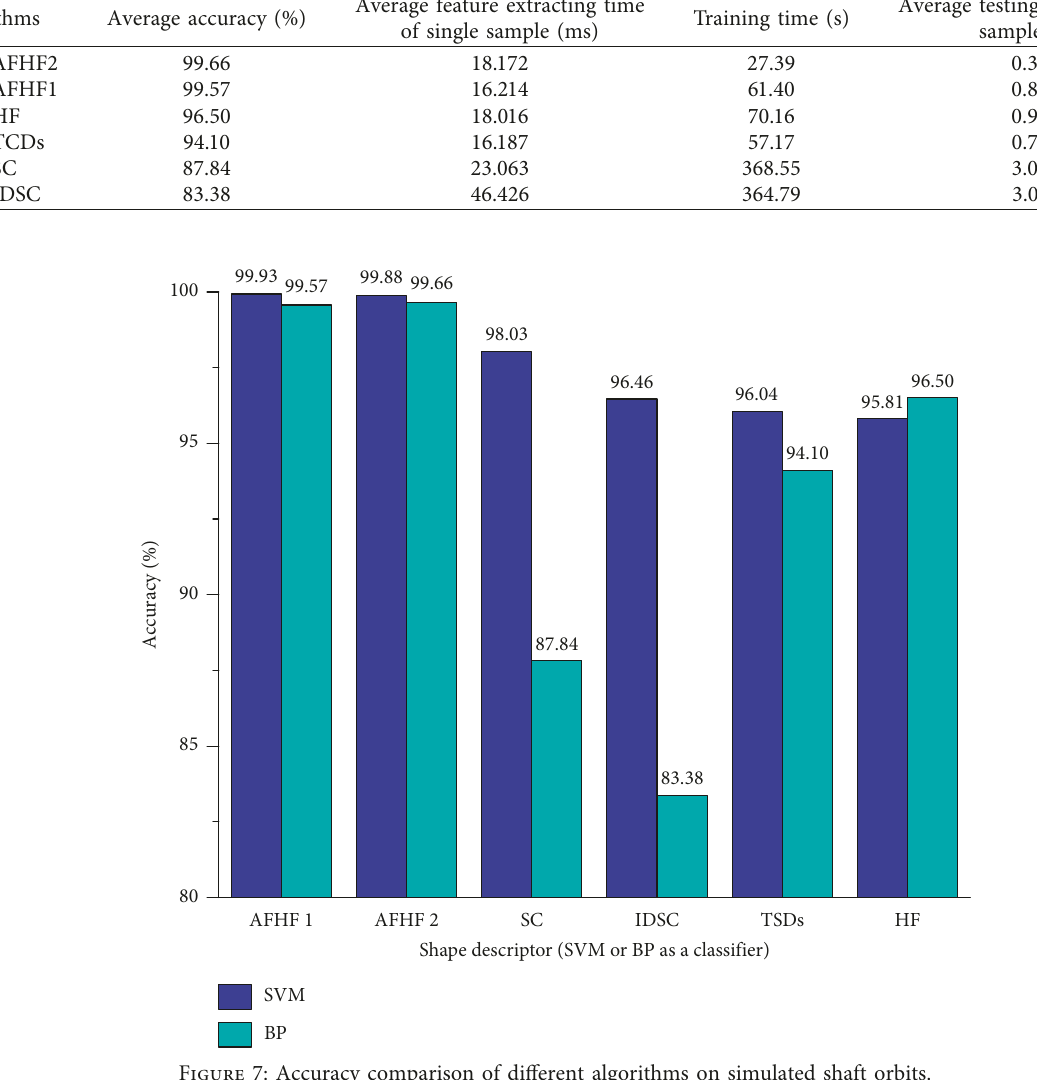
Figure 7: Accuracy comparison of different algorithms on simulated shaft orbits.